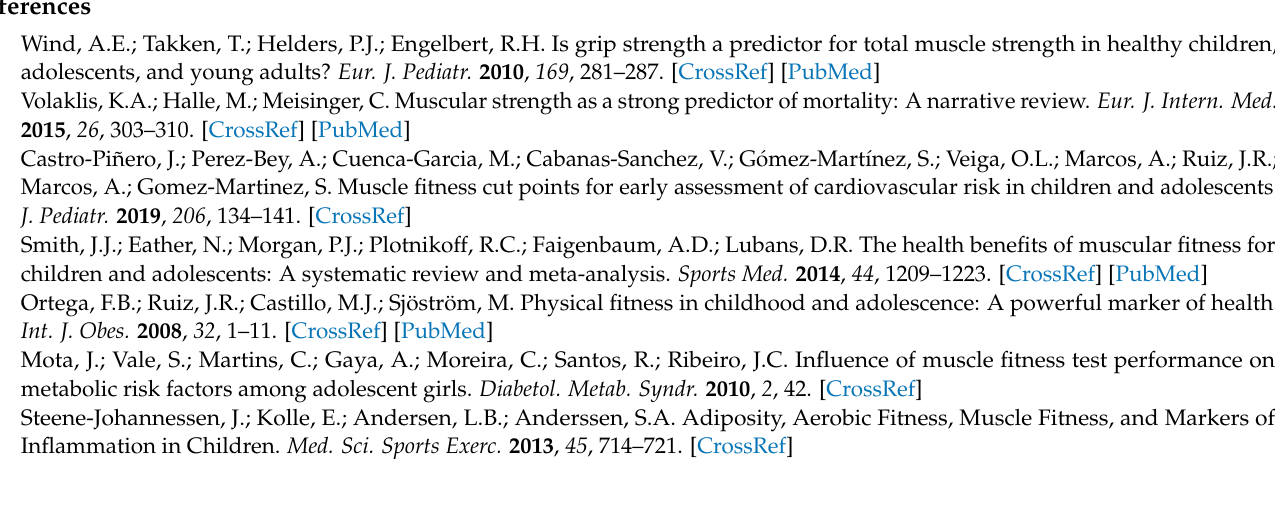
Figure S1: Funnel plot of publication